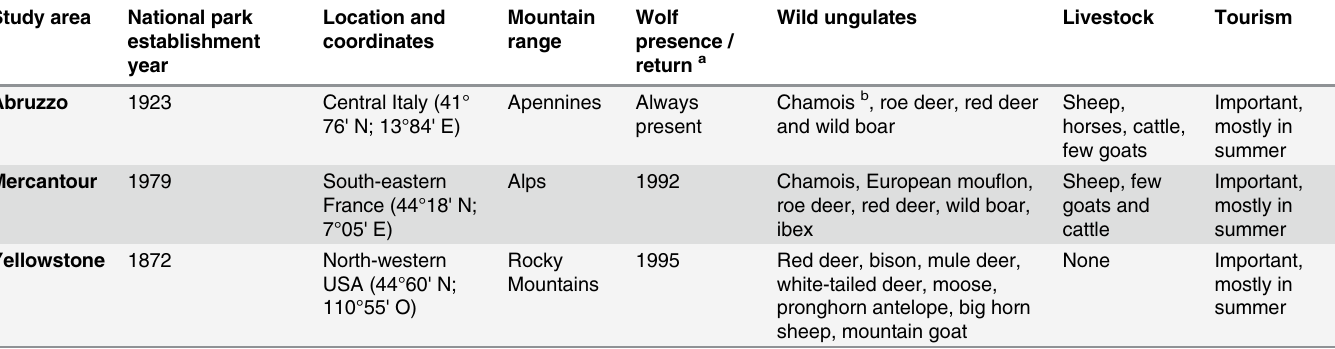
Table 1. Characteristics of the three study